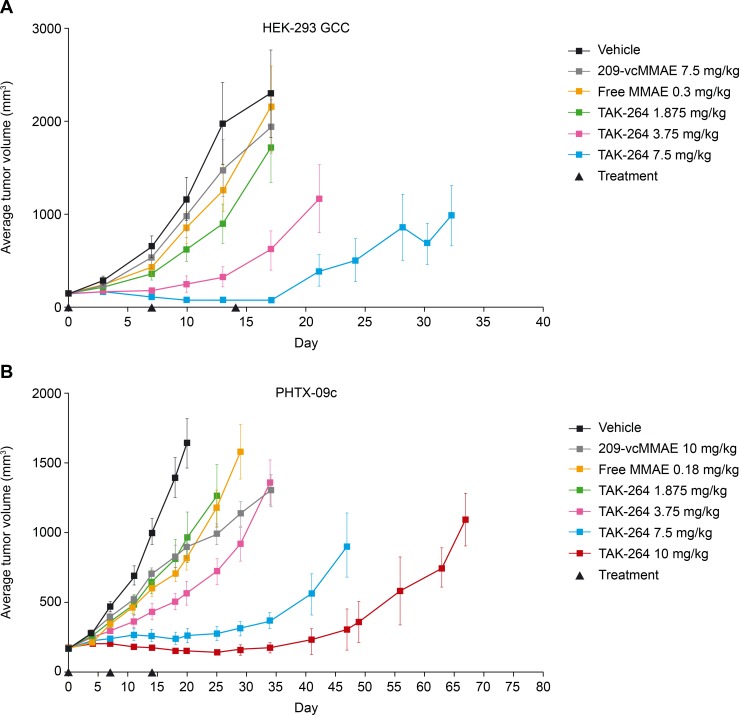
TAK-264 induces tumor regression and long-term tumor growth delay of GCC-expressing tumors.Female SCID mice bearing (A) GCC-expressing HEK293 xenograft tumors and (B) PHTX-09c tumors, a patient-derived xenograft model of mCRC, were treated when the tumor reached approximately 200 mm3 with either vehicle, non-targeting control antibody 209-vcMMAE, free MMAE, or TAK-264 at various doses on a weekly dosing schedule indicated by the black triangles. Average tumor volume was determined at multiple time points following start of treatment and is shown ± S.E.M.